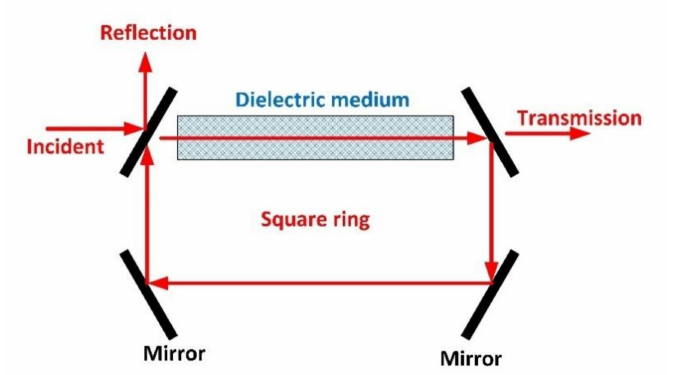
Figure 2. Traditional Akimoto’s system.